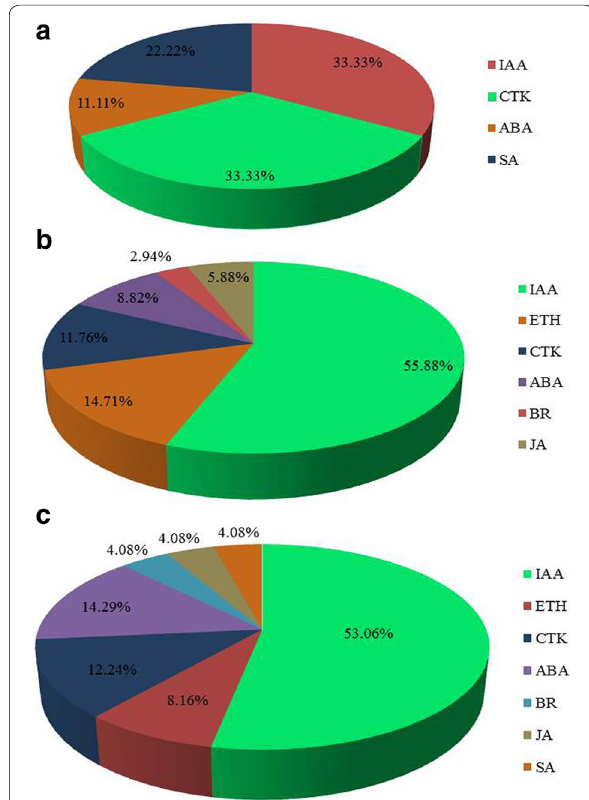
Fig. 5 The proportion of differently expressed genes (DEGs) related to plant hormone signaling pathways in a pairwise R4B1-5-vs-R2B1-5, b pairwise R4B1-10-vs-R2B1-10 and c R2B1 library. IAA auxin, CTK cytokine, ABA abscisic acid, SA salicylic acid, ETH ethylene, BR brassinolide, JA jasmonic